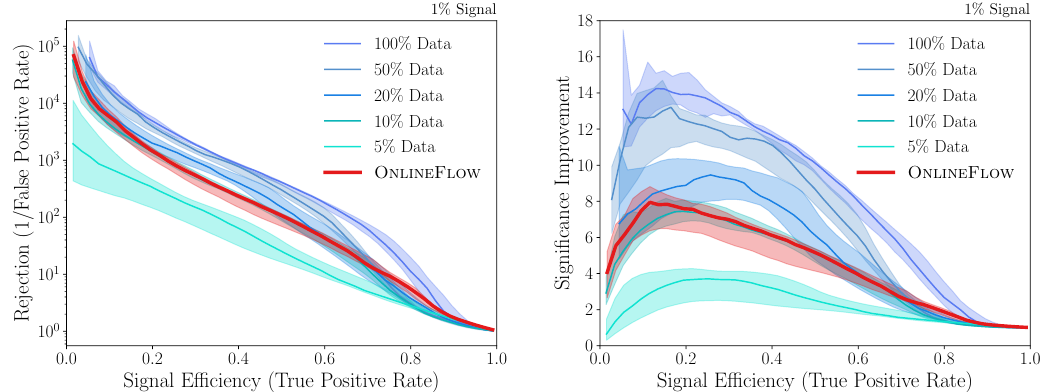
Figure 9: ROC (left) and significance improvement (right) for the CWoLa benchmark approach, based on a decreasing amount of data, compared with the O NLINE F LOW . The signal fraction is 1%. Vertical order of the Data lines corresponds to their order in the